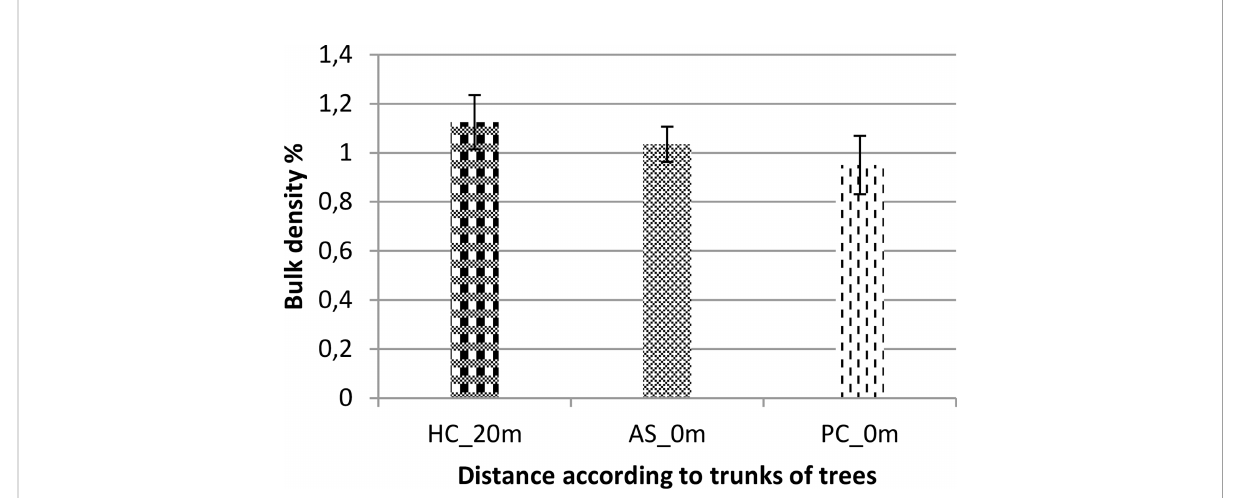
FIGURE 4 Soil bulk density based on the distance to the trunks of trees. AS, Vachellia seyal ; Pc, Prosopis chilensis ; HC, out of cover of